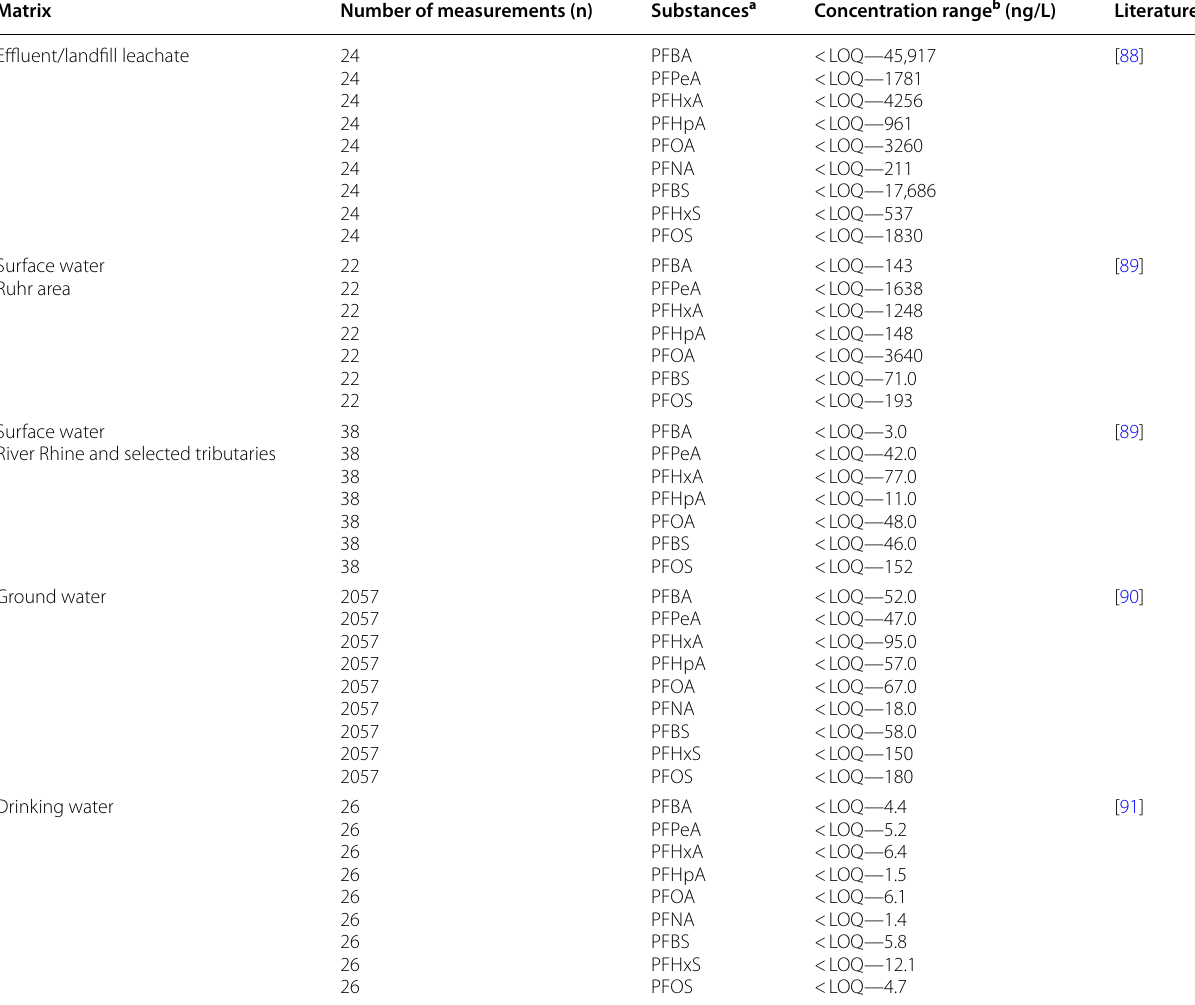
Table 1 Findings of PFC in aqueous